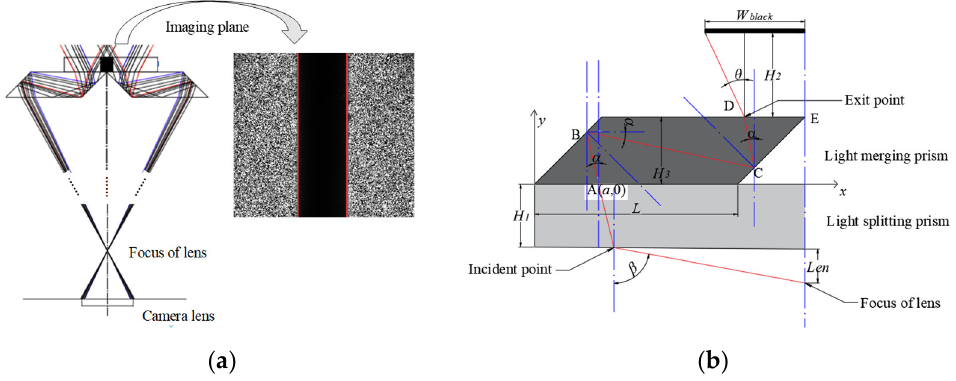
Figure 6. Rhombic prism model. ( a ) Rhombic prism imaging model. ( b ) Geometric parameter